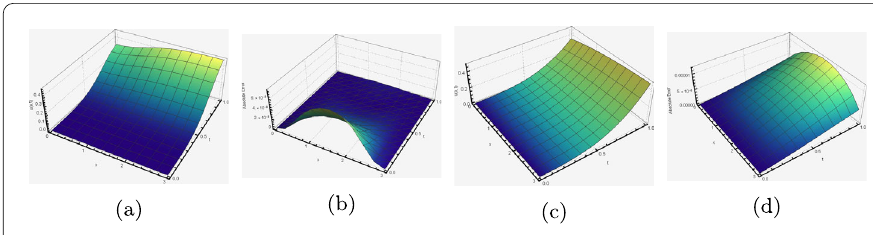
Figure 12 ( a ) and ( b ) represent approximate solution and absolute error distribution, respectively, using SJSCM. ( c ) and ( d ) represent approximate solution and absolute error distribution, respectively, using the